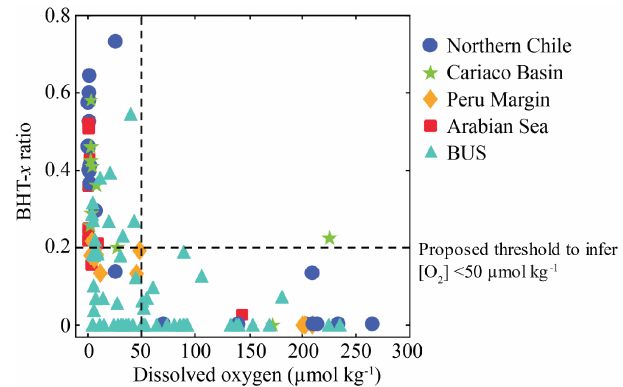
Figure 9. Relationship between dissolved oxygen concentration and the BHT- x ratio in suspended particulate matter (SPM) col- lected from the water columns of northern Chile (Matys et al., 2017); the Cariaco Basin, Peru Margin and Arabian Sea (Sáenz et al., 2011); and the Benguela upwelling system (BUS; this study). Figure adapted from Sáenz et al. (2011) and Matys et al.